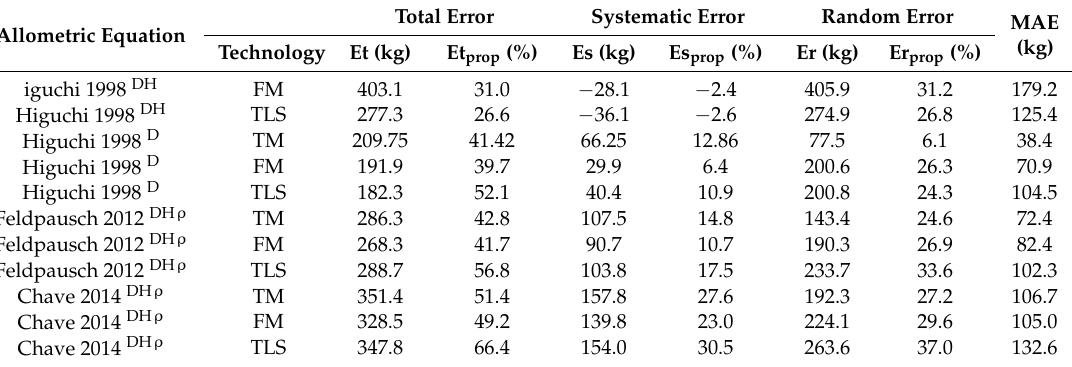
Table 3. The metrics of error among the local and pantropical equations estimating tropical aboveground biomass: For each allometric equation, we used input data from respective instruments evaluated in this study, i.e., diametric/metric tape (TM), Field-Map bundle (FM), and terrestrial laser scanner (TLS). The Mean Absolute Error (MAE) is the difference between the respective estimate and the reference estimate based on the destructive sampling of local tree individuals. D, input is only diameter; DH, input is diameter and height; DH ρ , input is diameter, height, and wood